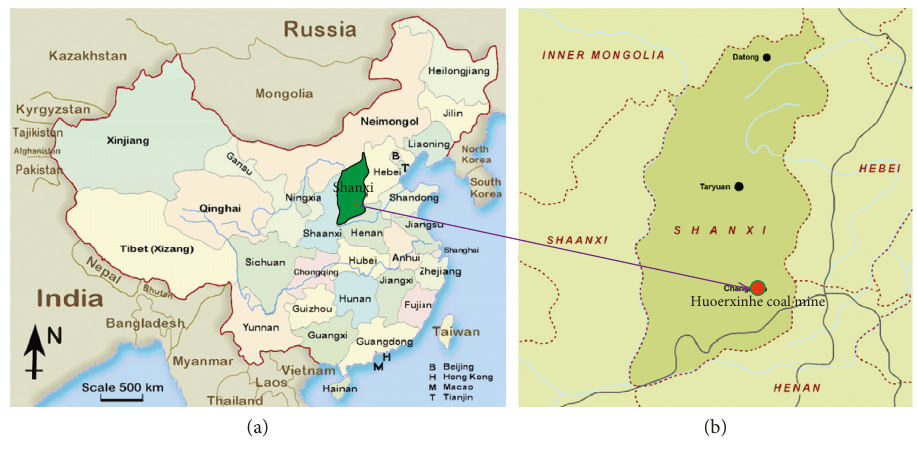
Figure 2: Location of Huoerxinhe coal mine.